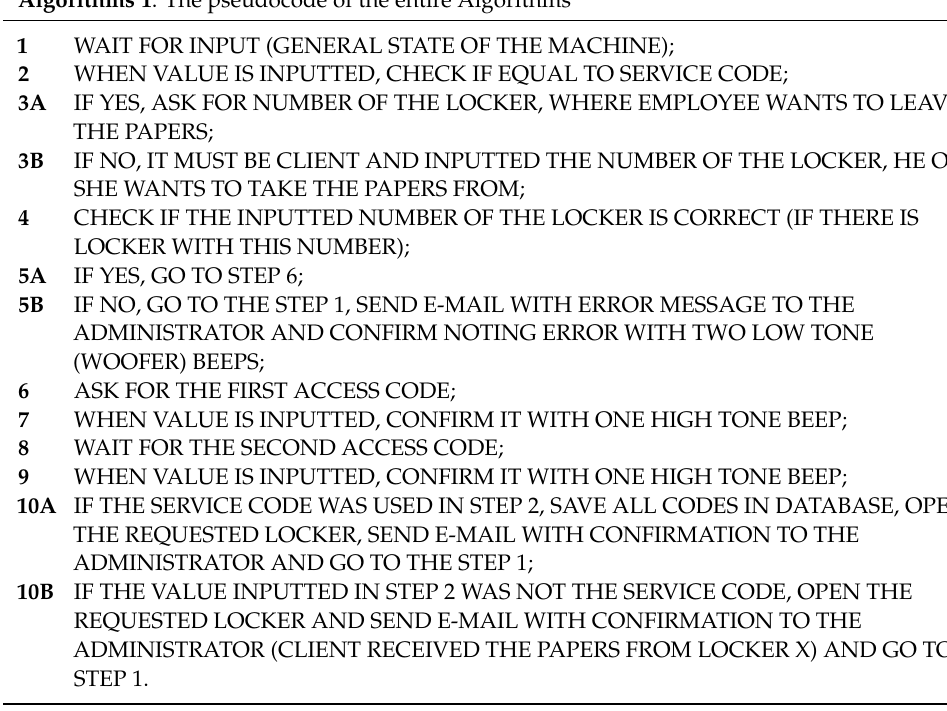
Figure 8. The fragment of the code in Python programming language.